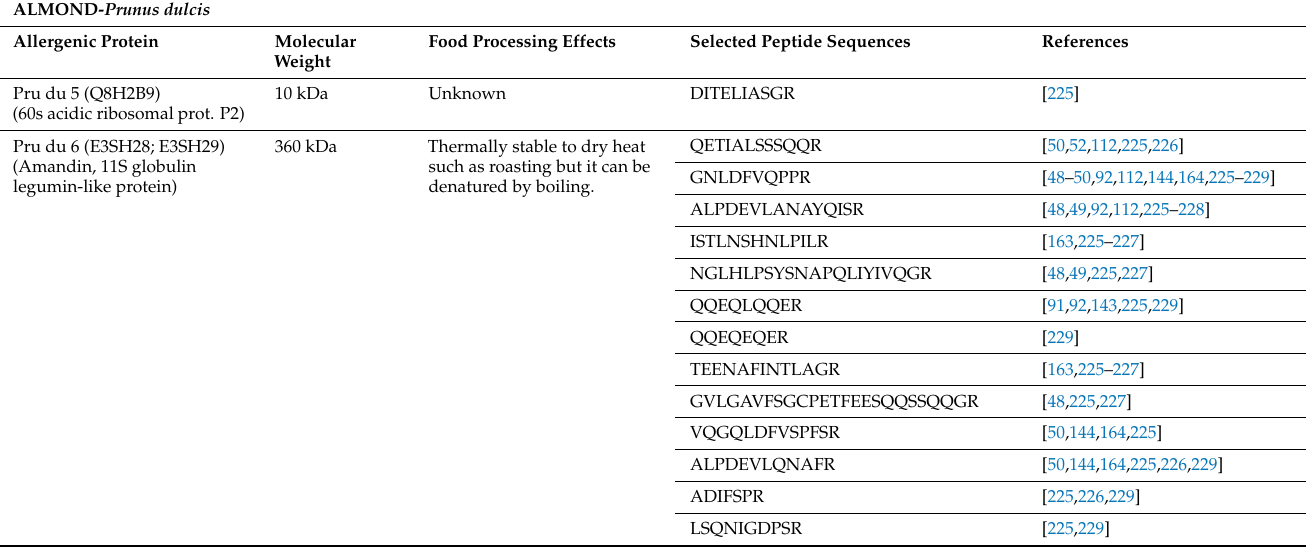
Table 2. Collection of the main allergenic proteins of almond, hazelnut, pistachio, cashew, walnut, and peanut and of peptides exploited for their identification and quantifications as hidden allergens in food products using analytical approaches based on mass